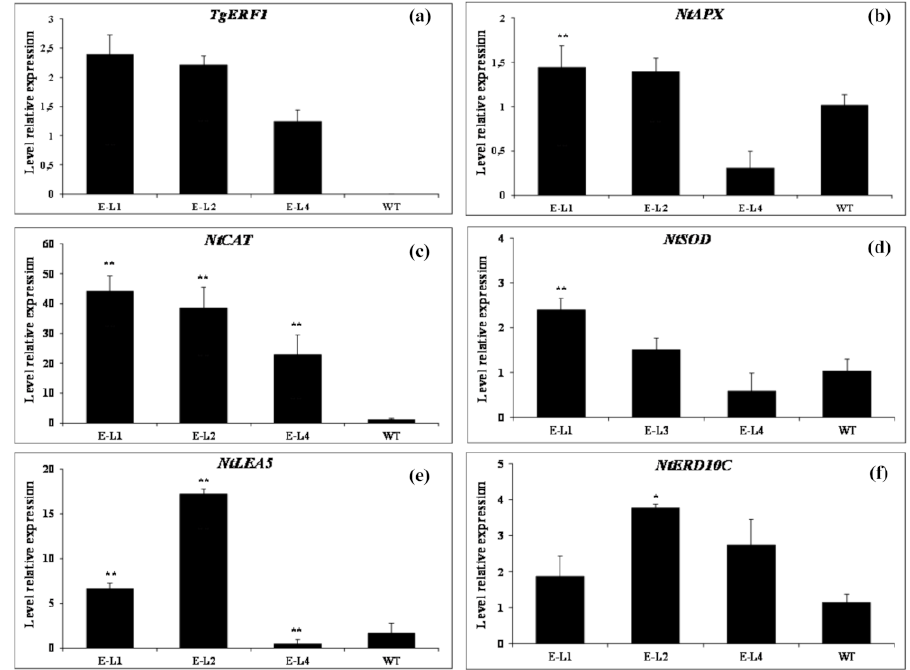
Figure 13. Relative expression of stress responsive genes at ten days of drought treatment. ( a ) Char- acterization of expression levels of the TgERF1 transgene. ( b – f ) Stress responsive genes NtAPX , NtCAT , NtSOD , NtLEA5 , NtERD10C . Total RNA was isolated from plant leaf tissues at ten days of drought stress. Measured parameters were performed at 40 days after sowing (DAS). The constitutive NtEF1 α housekeeping gene was used as internal control. Data are presented as means ± SEM of three biological replicates. Significant differences were determined by ANOVA followed by Dunnett’s